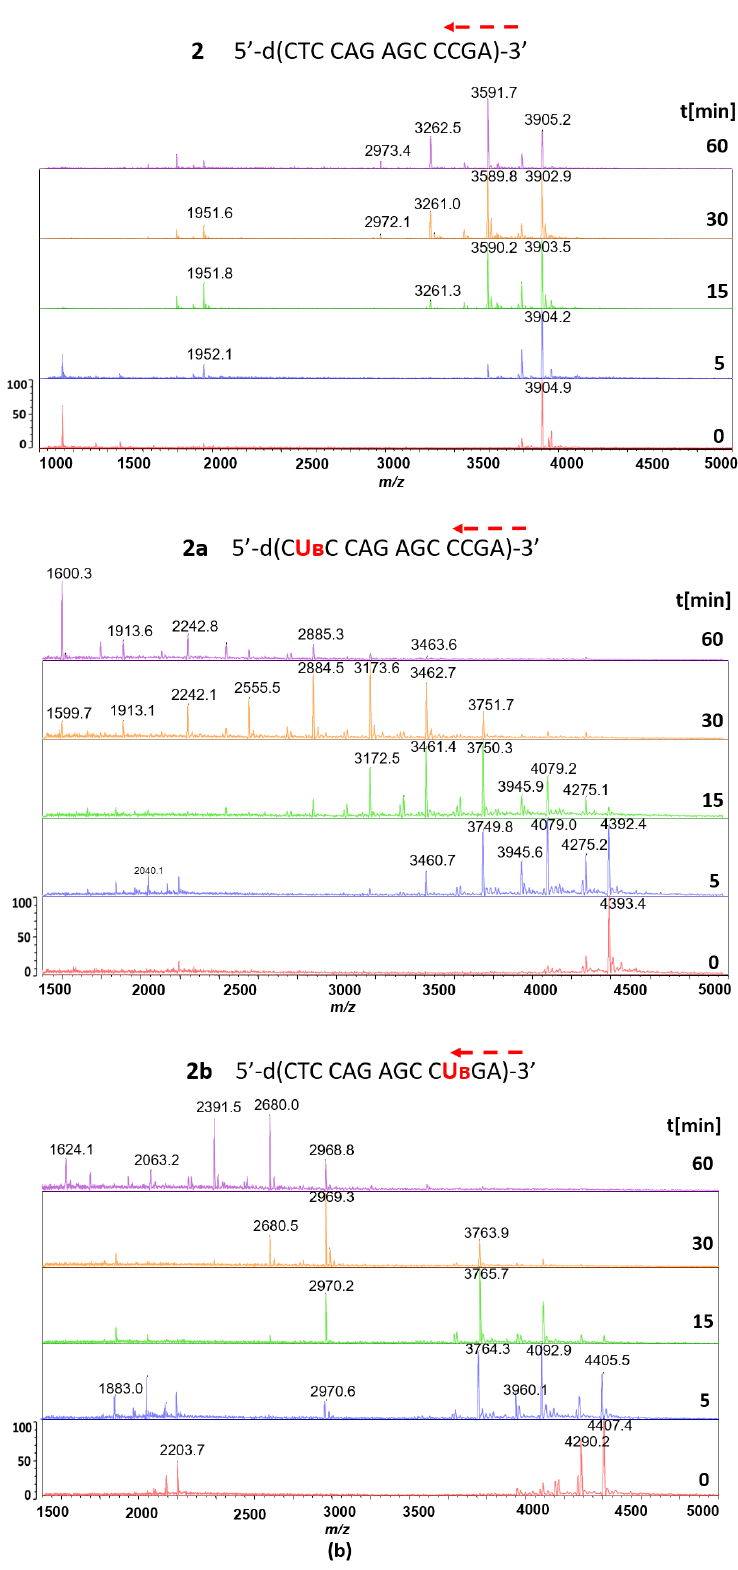
Figure 3. MALDI-TOF mass spectra of the hydrolysates of oligonucleotides 1 , 1a, 1b (panel a ) 2 , 2a and 2b (panel b ) after 0, 5, 15, 30 and 60 min of treatment with svPDE. The experimental conditions are described in the Materials and Methods section.